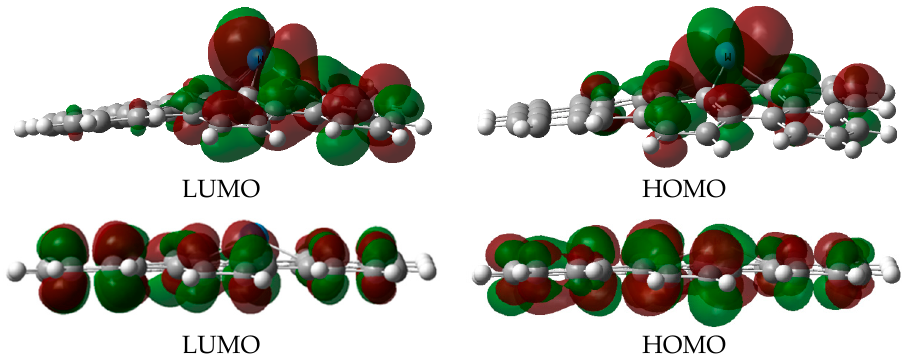
Figure 2. Frontier molecular orbits of W-SV-graphene and W-DV-graphene.